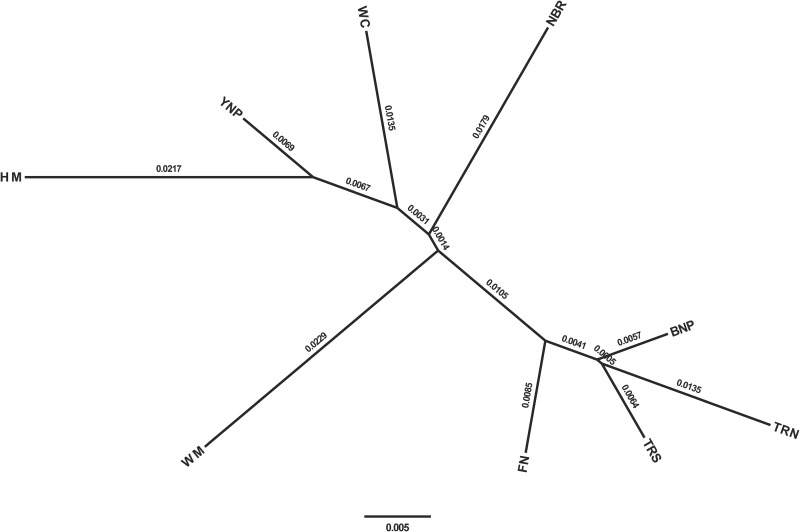
Dendrogram.Unrooted tree diagram with maximum likelihood scores comparing Henry Mountain bison samples to 8 US federal herds using 40 polymorphic loci. See Fig 2 for herd name abbreviations.